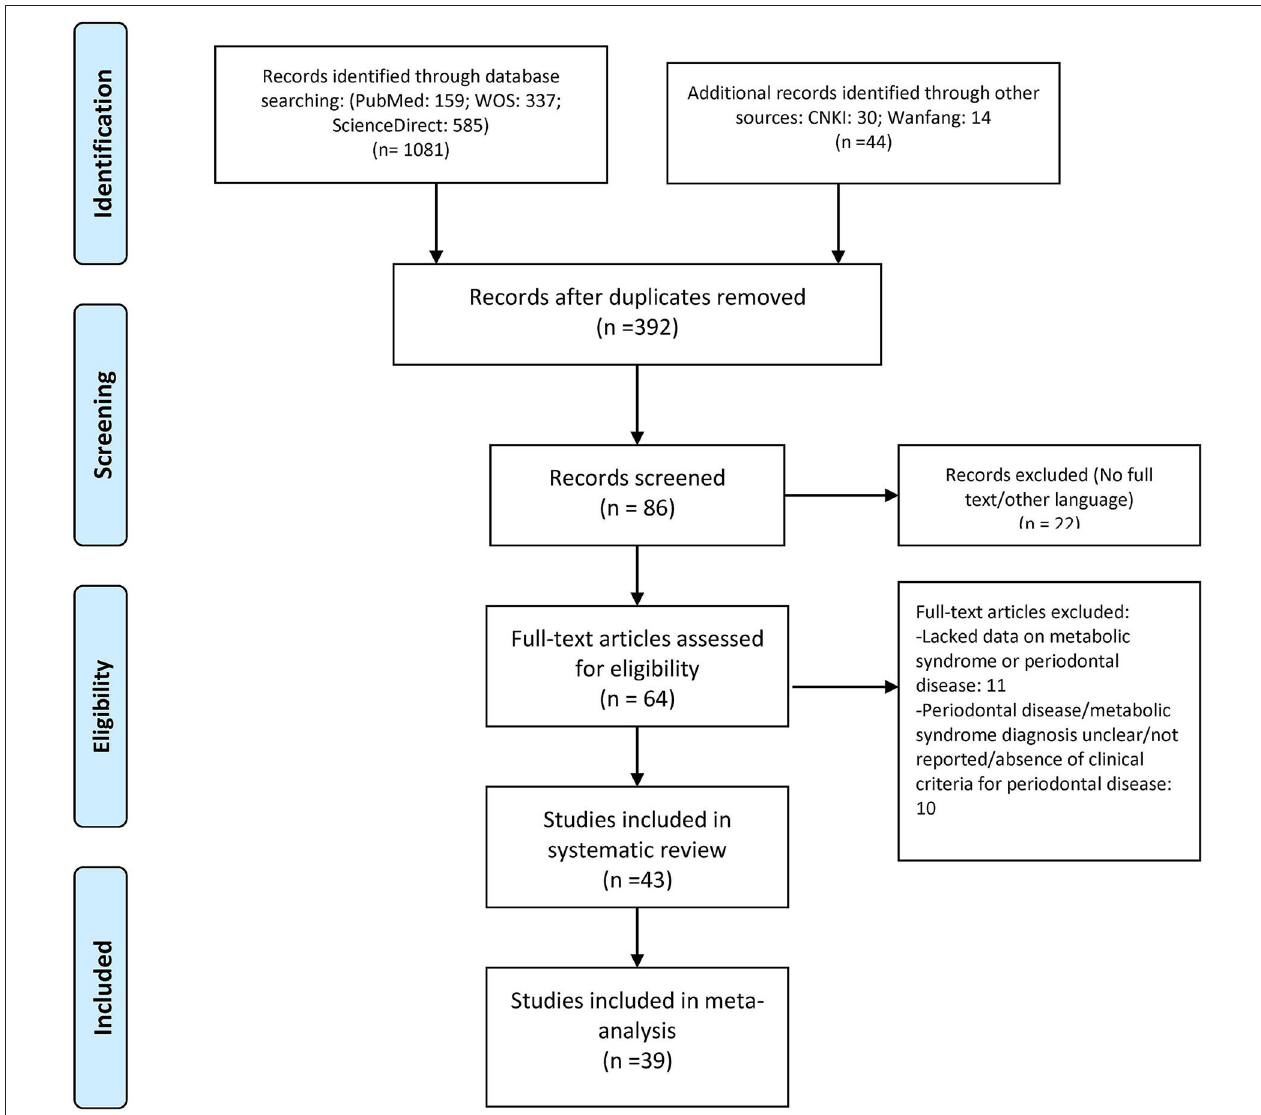
FIGURE 1 | PRISMA flowchart of the search for studies and their selection and